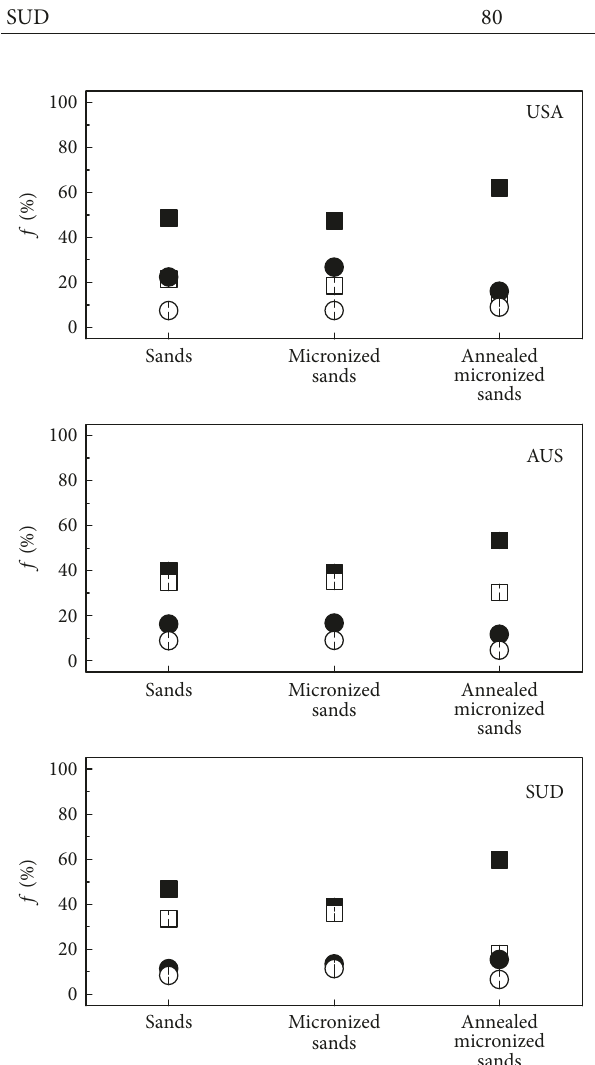
Figure 4: PAC relative fractions evolution determined for the natural, the micronized, and the annealed micronized zircon sands. Symbols represent the relative fractions of the four hyperfine interactions reported in Table 3: 𝐼 1 (full square), 𝐼 2 (open square), 𝐼 𝐼 3 (full circle), and 4 (open circle).